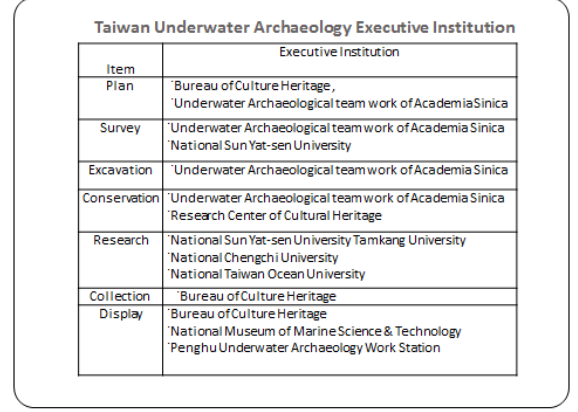
Figure 2. Taiwan underwater archaeology executive